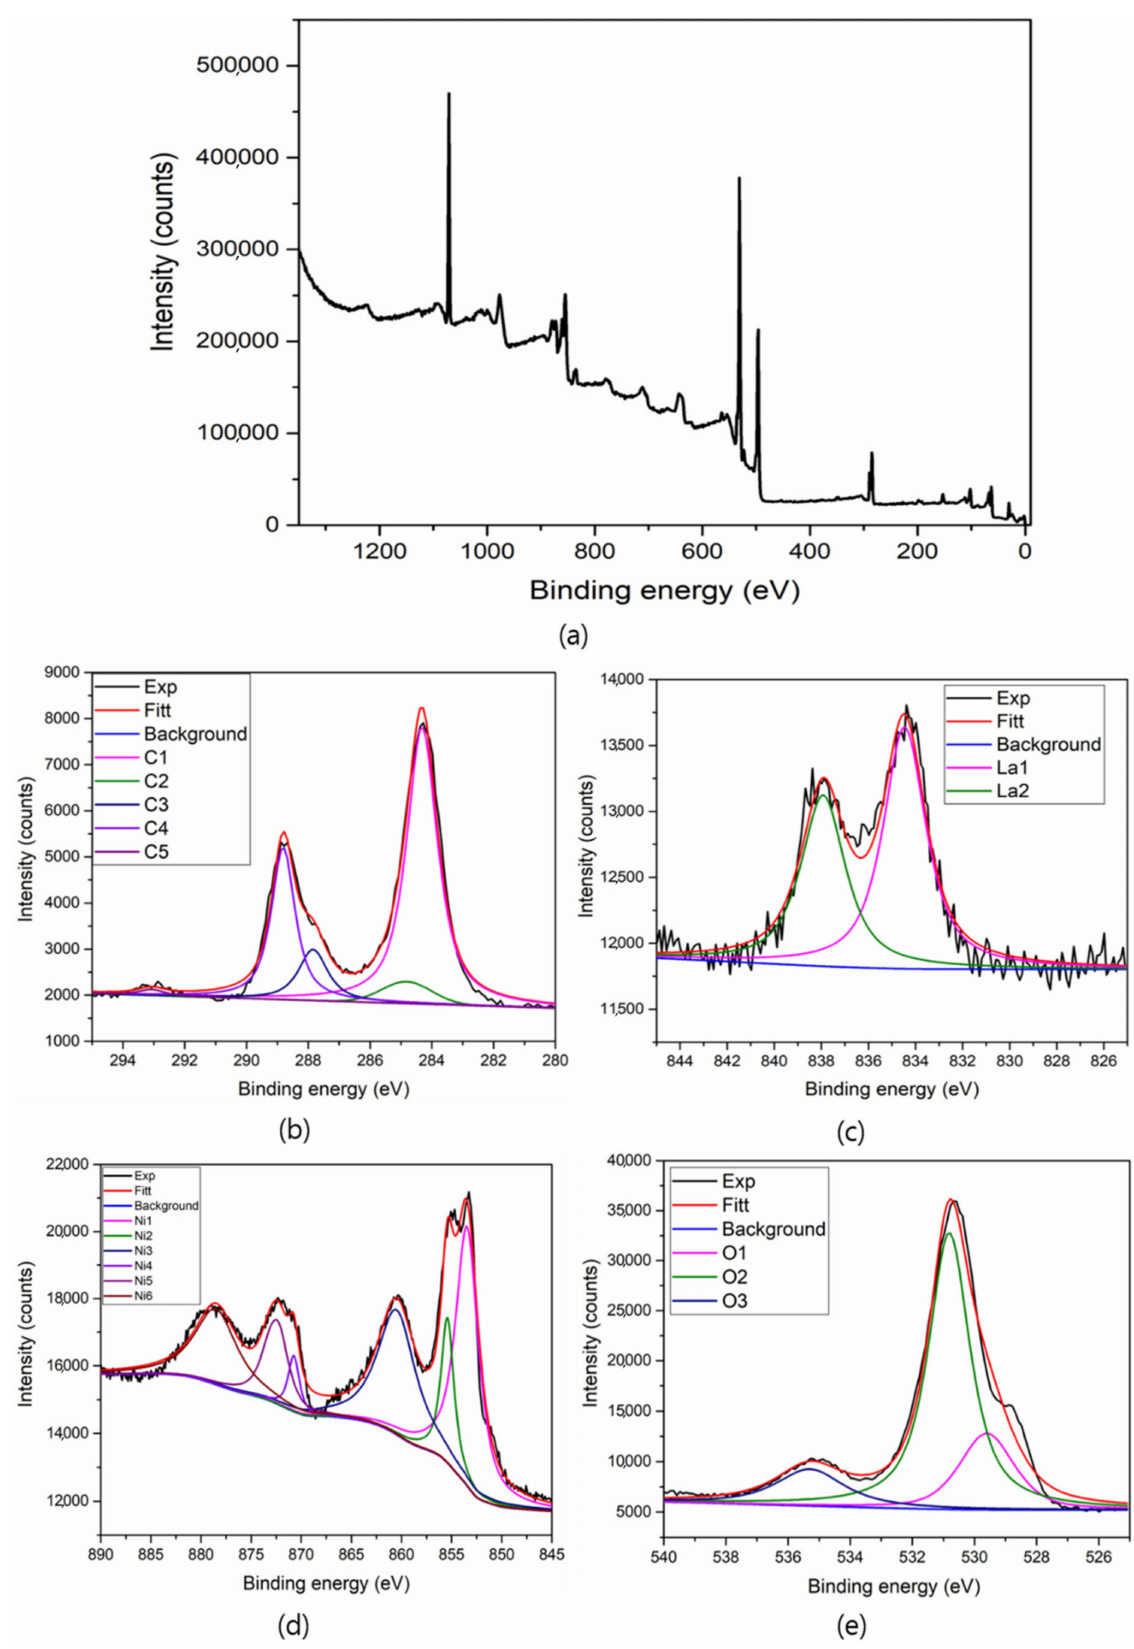
Figure 6. XPS spectra of NiOLa-04 nanoparticles: ( a ) survey scan; ( b ) carbon; ( c ) lanthanum; ( d ) nickel; and ( e ) oxygen